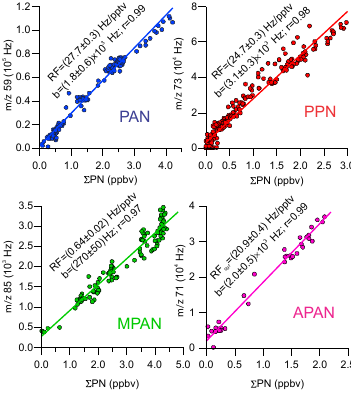
Figure A3. TD-CIMS calibration plots for PAN, PPN, MPAN, and APAN.